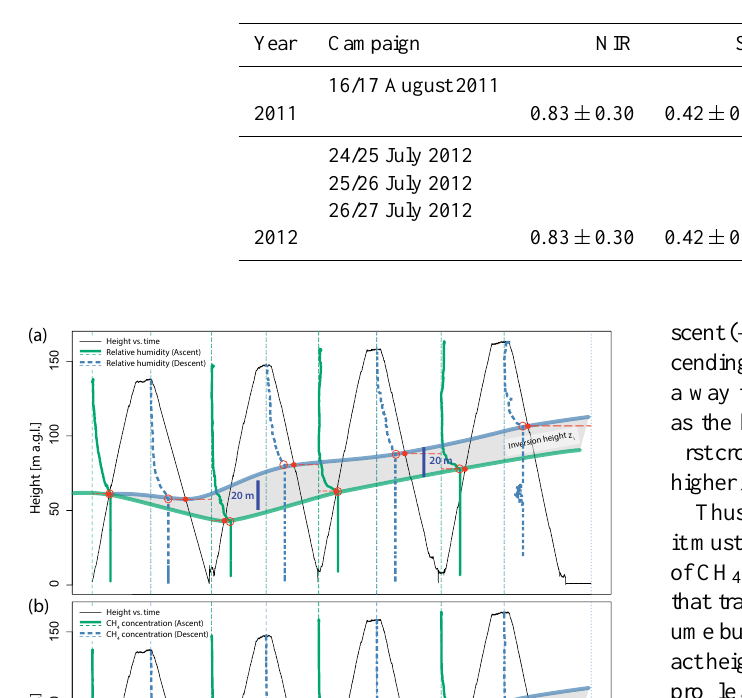
Table 2. Farm-scale CH 4 emission estimates from different inventories (NIR, SEI, and CHAI) and the NBL budget approach. The inventory estimates are based on the methodology recommended by the IPCC (see text for details). CHAI estimates use current stocking census data, whereas NIR and SEI estimates are both based on 2011 stocking census data. NBL budget fluxes are denoted as the mean of all budget fluxes from the individual balloon profiles of the respective nights. The fluxes are in µgCH 4 m − 2 s − 1 (mean ± SD).